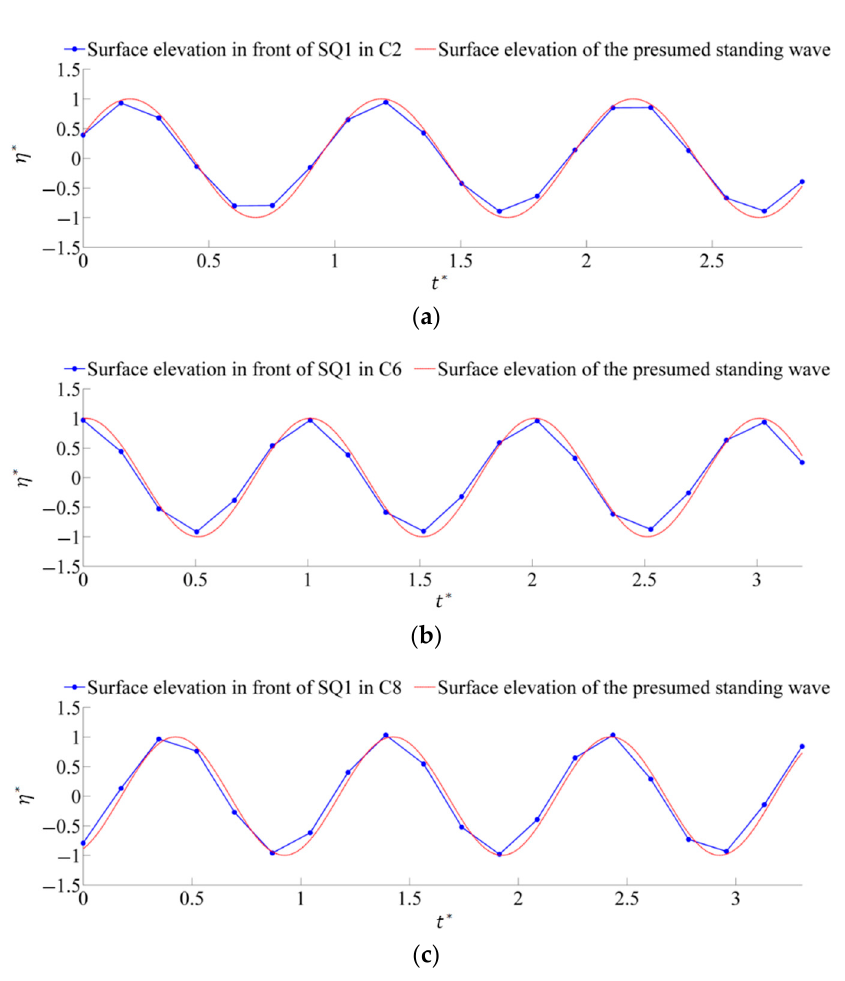
Figure 12. The comparison of the surface elevations in front of SQ1 with the presumed standing wave in front of SQ1: ( a ) for cases C2; ( b ) for case C6; ( c ) for case C8.